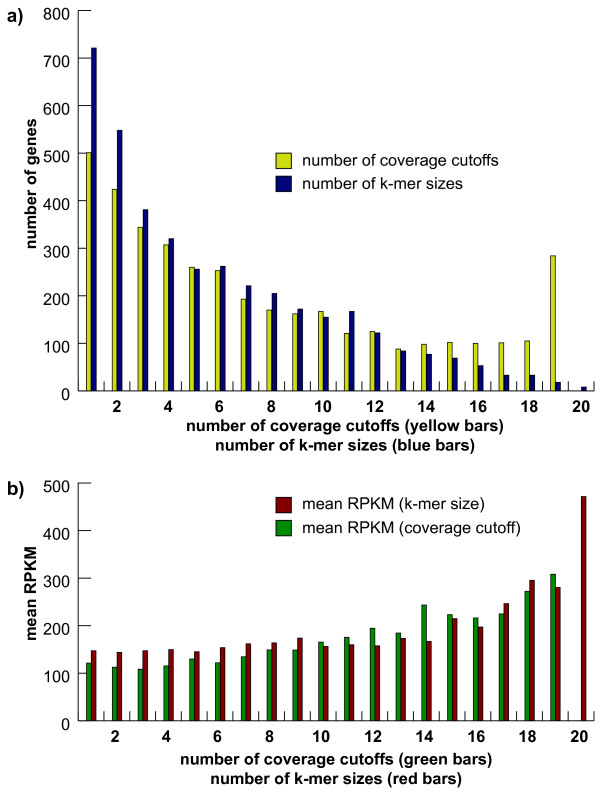
Number of genes assembled with a certain number of k-mer sizes and coverage cutoffs. a) For each of the 3,912 complete transcripts in the P. fastigiatum library the number of k-mer sizes (blue bars) and coverage cutoffs (yellow bars) leading to complete transcripts were counted. 721 genes were only assembled using one k-mer size and 501 using one coverage cutoff. b) Mean expression levels for genes assembled with a certain number of k-mer sizes and coverage cutoffs. For each set of genes that were completely assembled with the same number of k-mer sizes (red bars) and coverage cutoffs (green bars) a mean expression level was derived by computing the mean of the RPKM values (reads per kilobases and million mapped reads [30]). High positive Pearson correlation coefficients were found between the mean expression level and the number of k-mer sizes and coverage cutoffs.